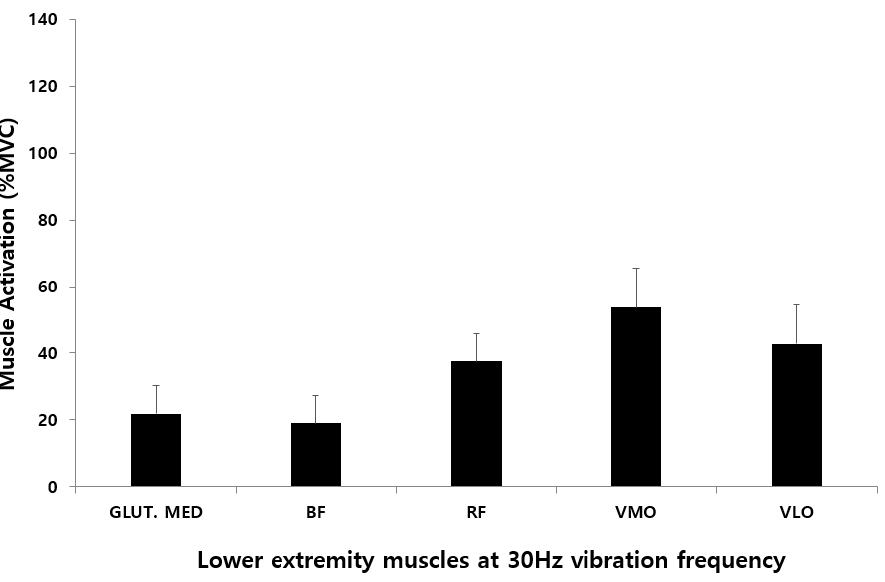
Figure 8. Results of muscle activation according to 30 Hz vibration frequency conditions